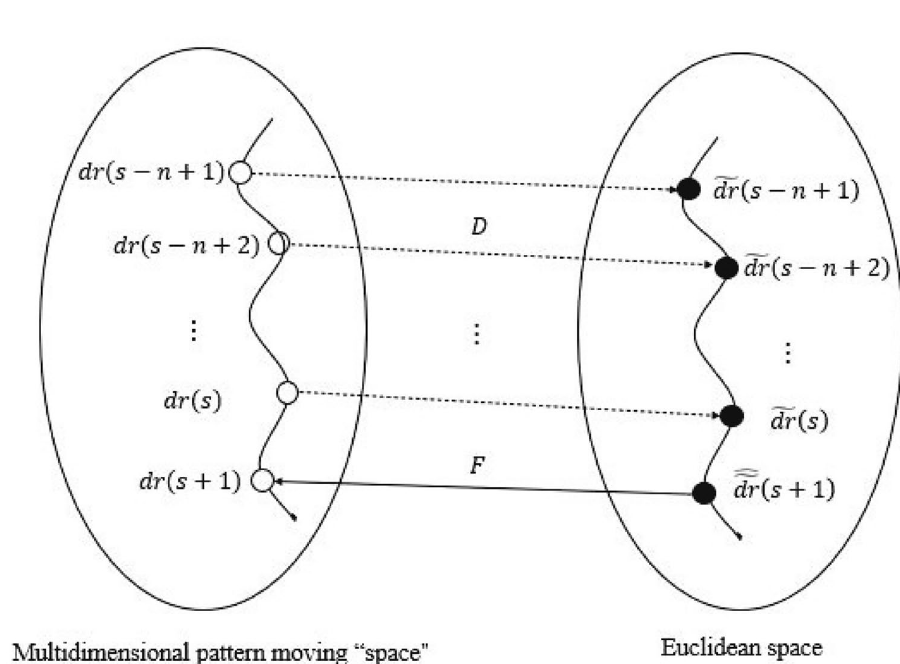
Fig. 2 System dynamics description based on moving